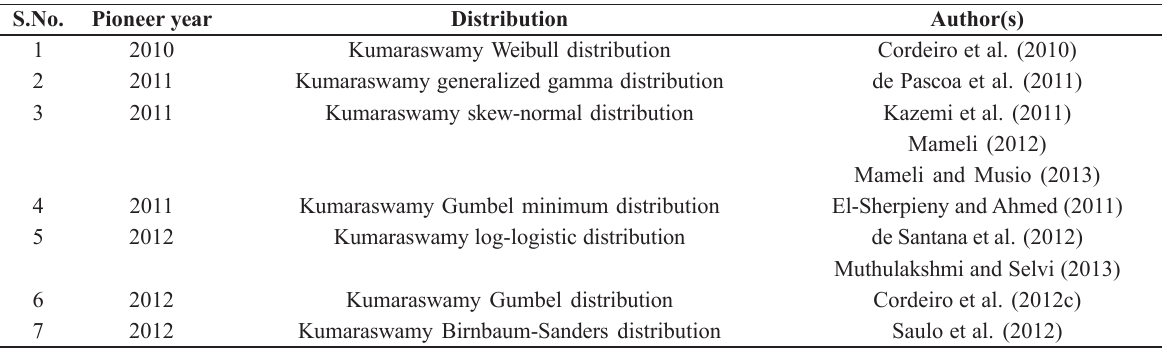
Contributed work on Kumaraswamy G family of